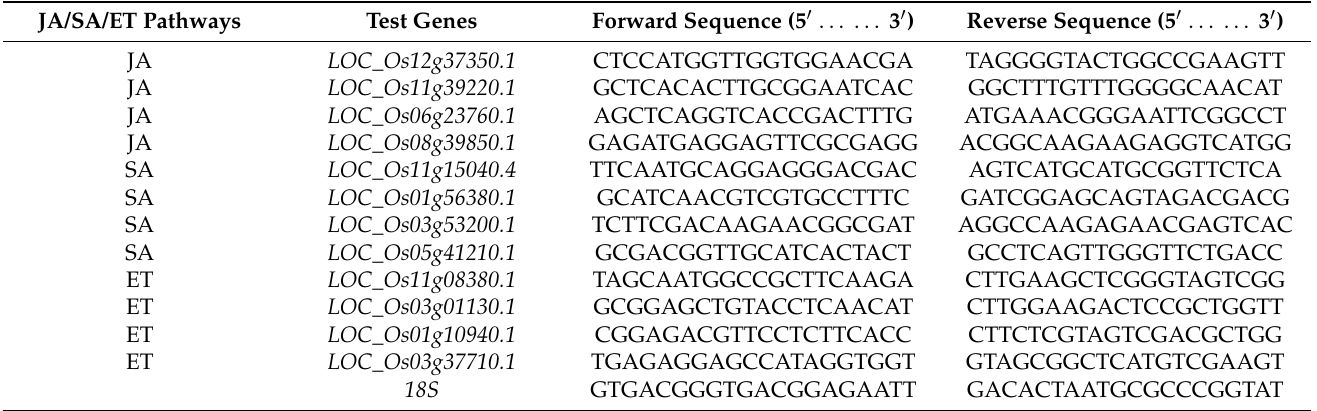
Table 1. Primers for all test genes of JA, SA, and